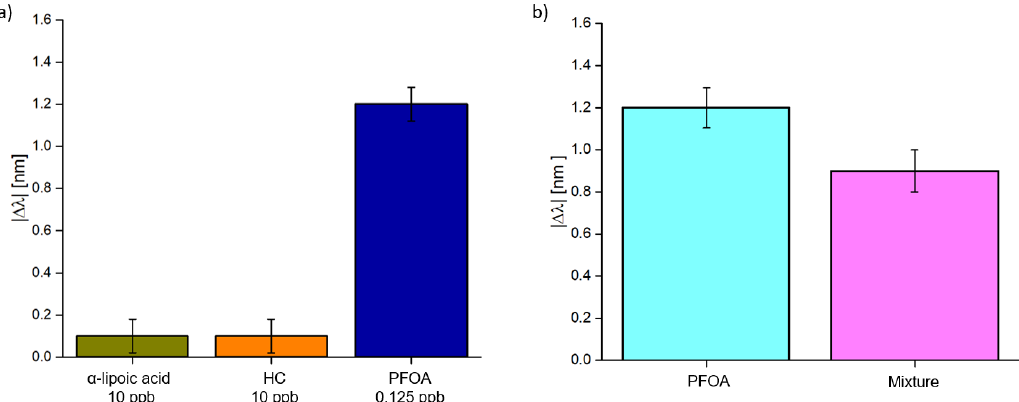
Figure 8. Selectivity test: ( a ) Absolute value of the resonance variation in other substances (hydrocarbons 10 ppb and α -lipoic acid 10 ppb) and the analyte (PFOA 0.125 ppb), measured one on one. ( b ) Comparison between the absolute value of the resonance variation relative to a PFOA concentration of 0.125 ppb without and with other compounds (hydrocarbons 10 ppb and α -lipoic acid 10 ppb).